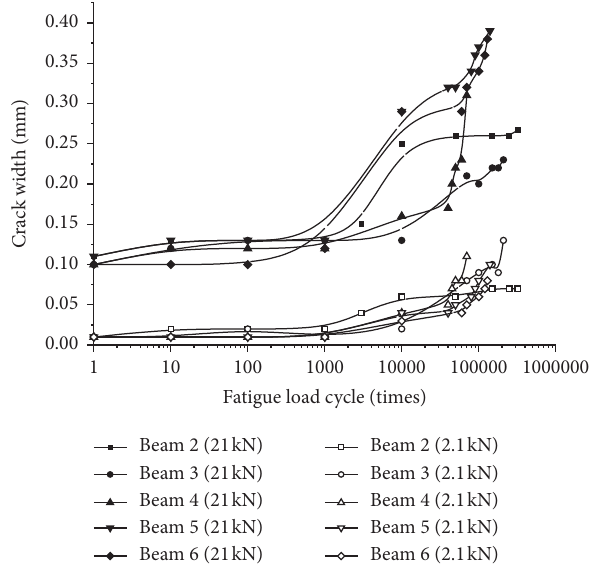
Figure 11: Crack width-fatigue cycle curve of each tested beam.